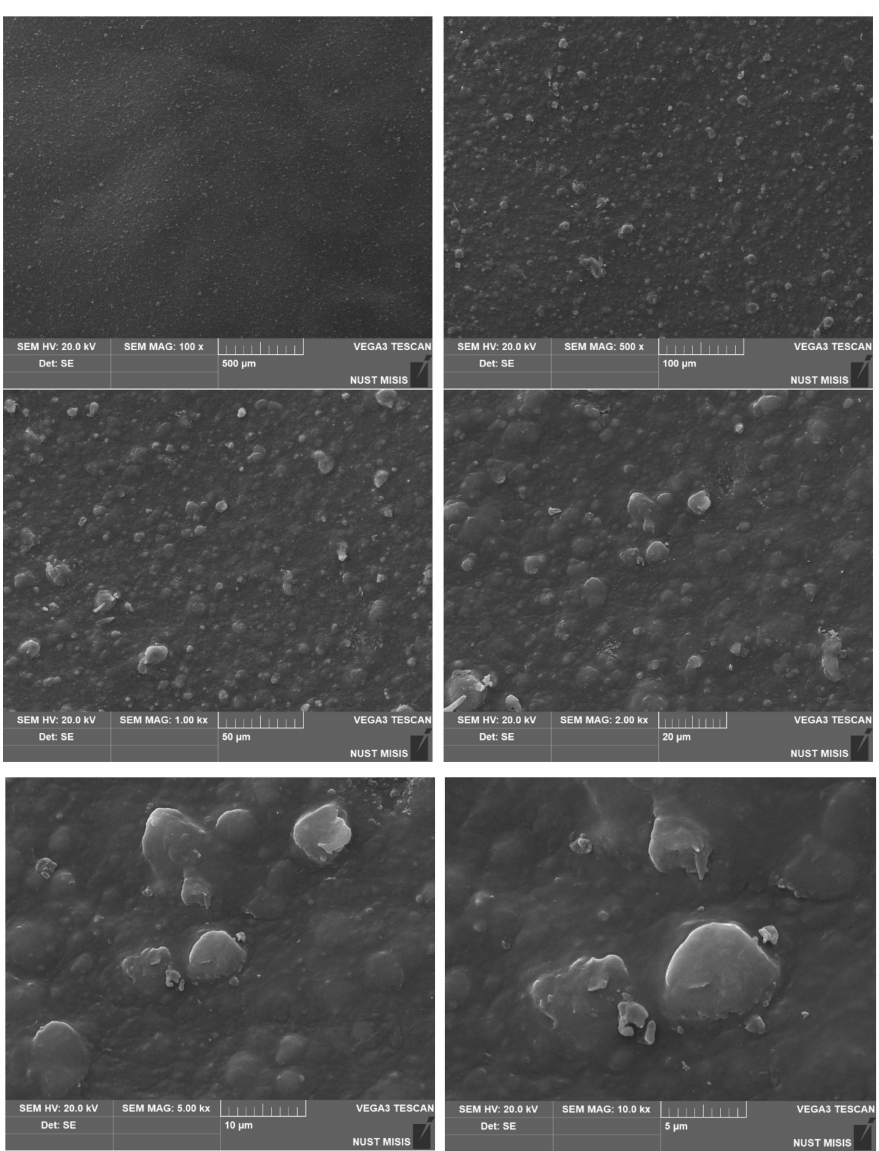
Figure 10. SEM images of the PLA/PBAT film surface before